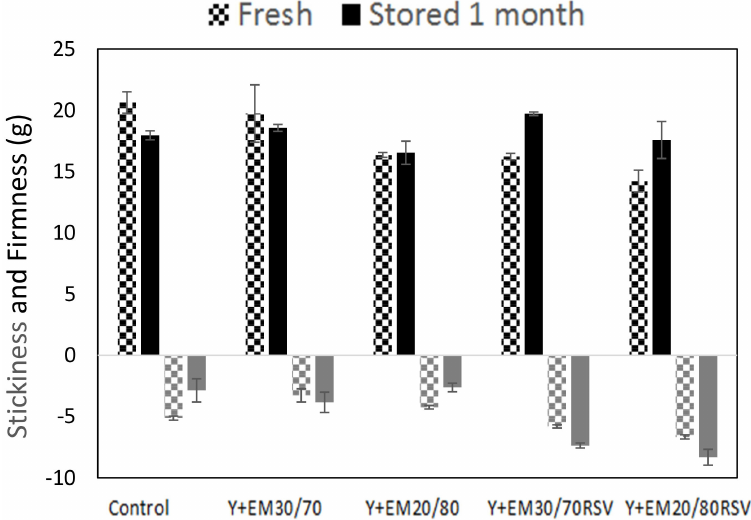
Figure 5. Firmness (above the X axis, in black colour) and stickiness (below the X axis, in grey colour) of the different types of yoghurts made comparing those that were fresh with those that were stored for 1 month at 4 ◦